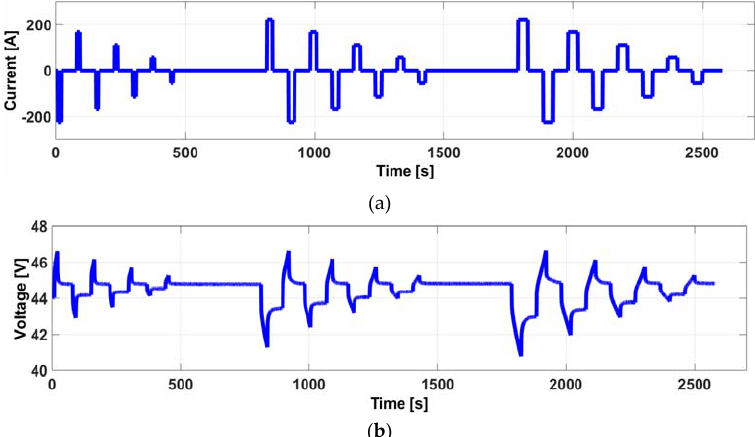
Figure 2. Discharging / charging current profile for the aging and experimental voltages of the fresh 12S28P NCA series / parallel battery pack: ( a ) discharging / charging current profile for aging, and ( b ) experimental discharging / charging voltage.